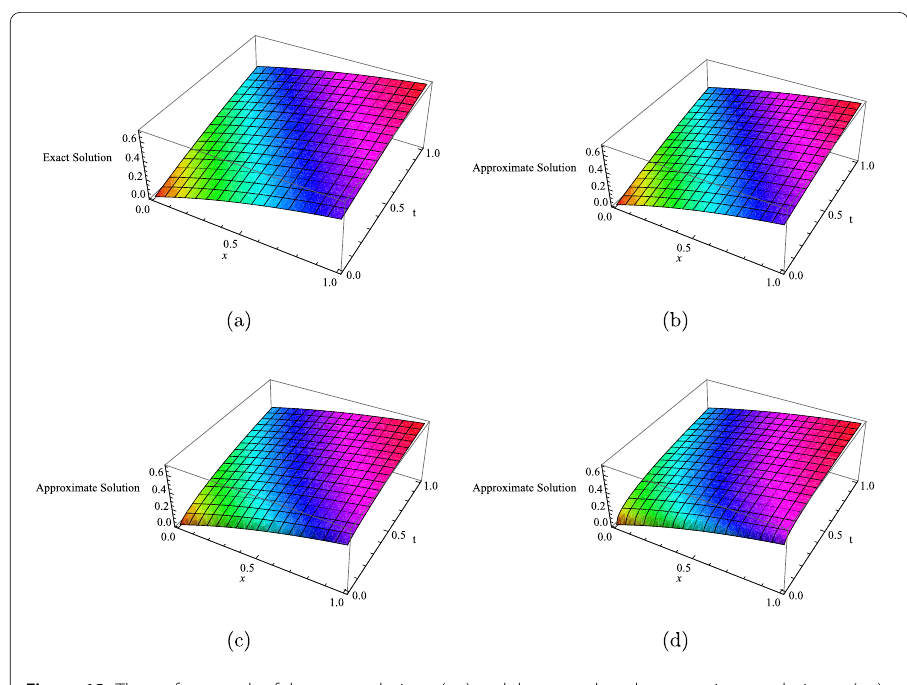
Figure 13 The surface graph of the exact solution u ( x , t ) and the seventh-order approximate solution u 7 ( x , t ) of Eq. (4.11): ( a ) u ( x , t ) when λ = 1, ( b ) u 7 ( x , t ) when λ = 1, ( c ) u 7 ( x , t ) when λ = 0.75, ( d ) u 7 ( x , t ) when λ = 0.5